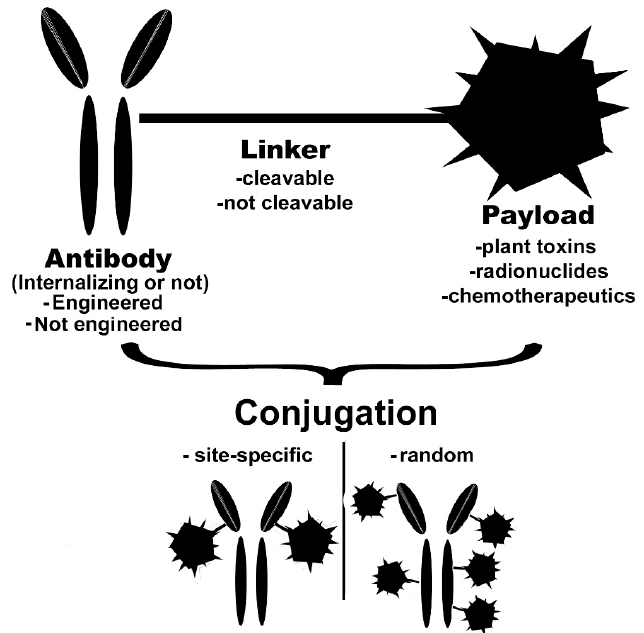
Figure 1. Schematic representation of various types of antibody-drug conjugates (ADCs) and their components.